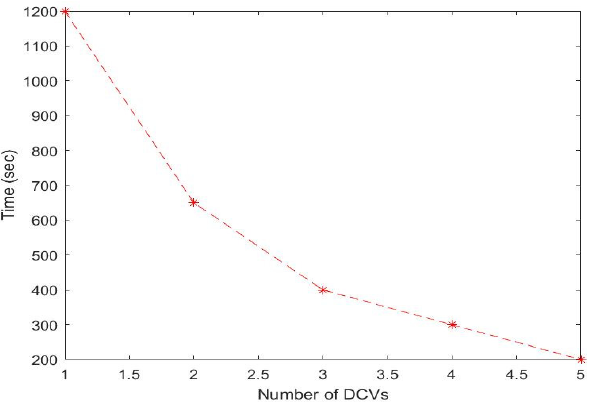
Figure 11. A working example of the proposed model using multiple DCVs.